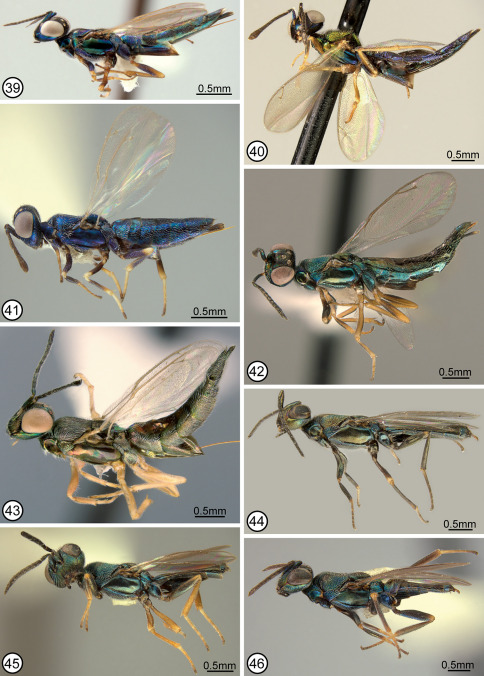
39−43 lateral ♀ habitus: 39 Calosota speculifrons (5) 40 Calosota panamaensis (holotype) 41 Calosota metallica (28) 42 Calosota acron (13) 43 Calosota setosa (1). 44−46 lateral ♂ habitus: 44 Calosota elongata (allotype) 45 Calosota longiventris (23) 46 Calosota aestivalis (18). Numbers in parentheses = CNC Photo 2009-no.